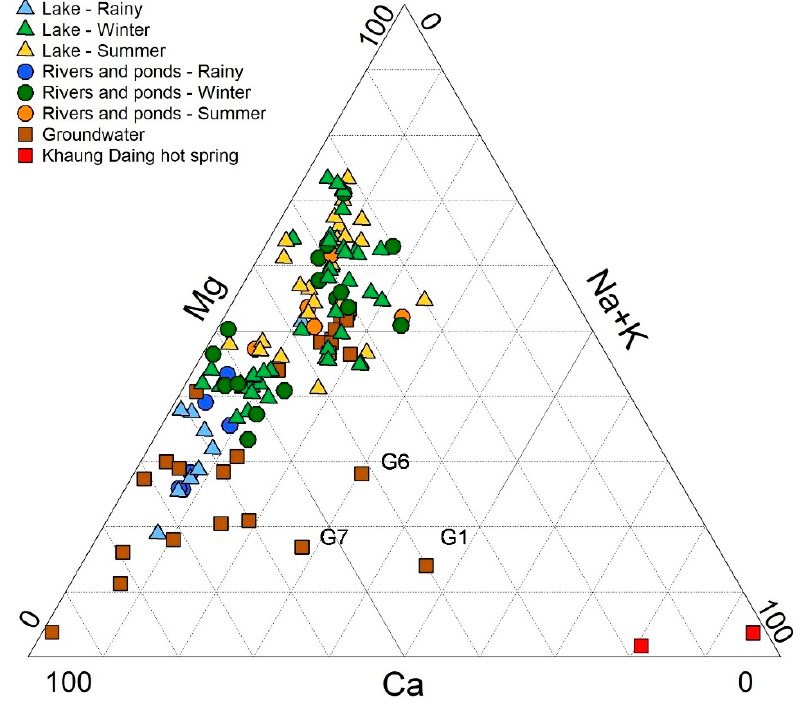
Figure 3. Relative cation abundance in surface and groundwater.